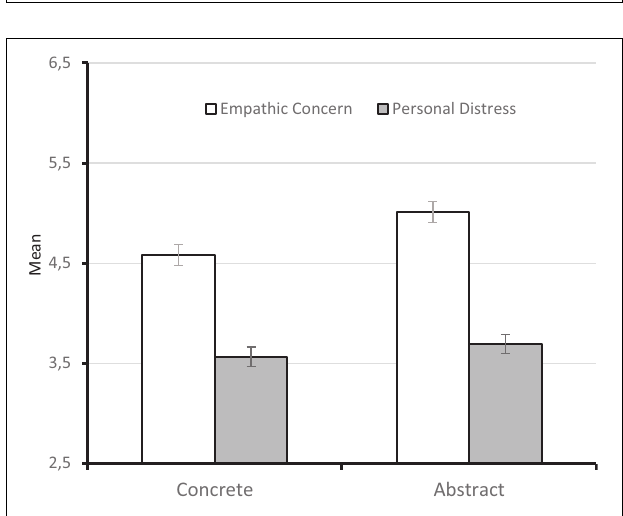
FIGURE 1 | Mean ratings of personal distress and empathic concern through session.